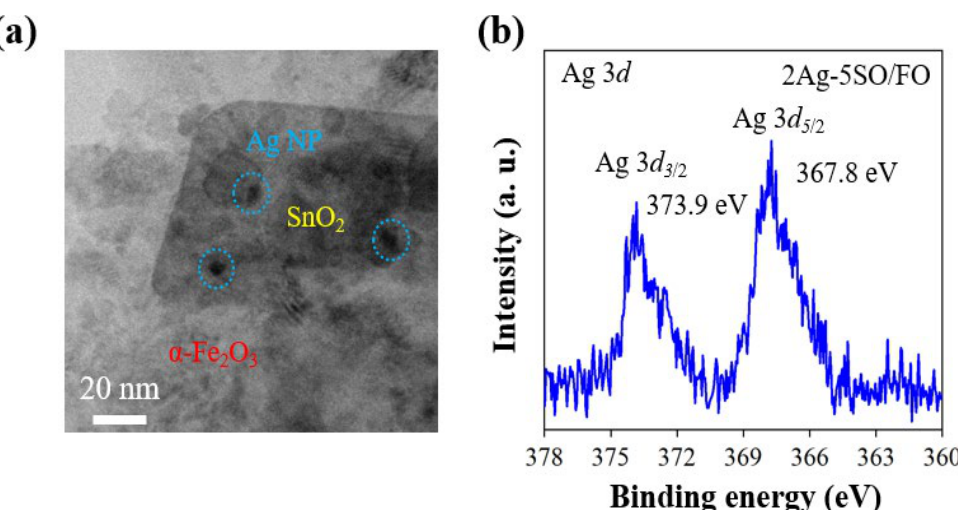
Figure 2. ( a ) TEM image and ( b ) XPS Ag 3 d spectrum of 2Ag-5SO/FO.